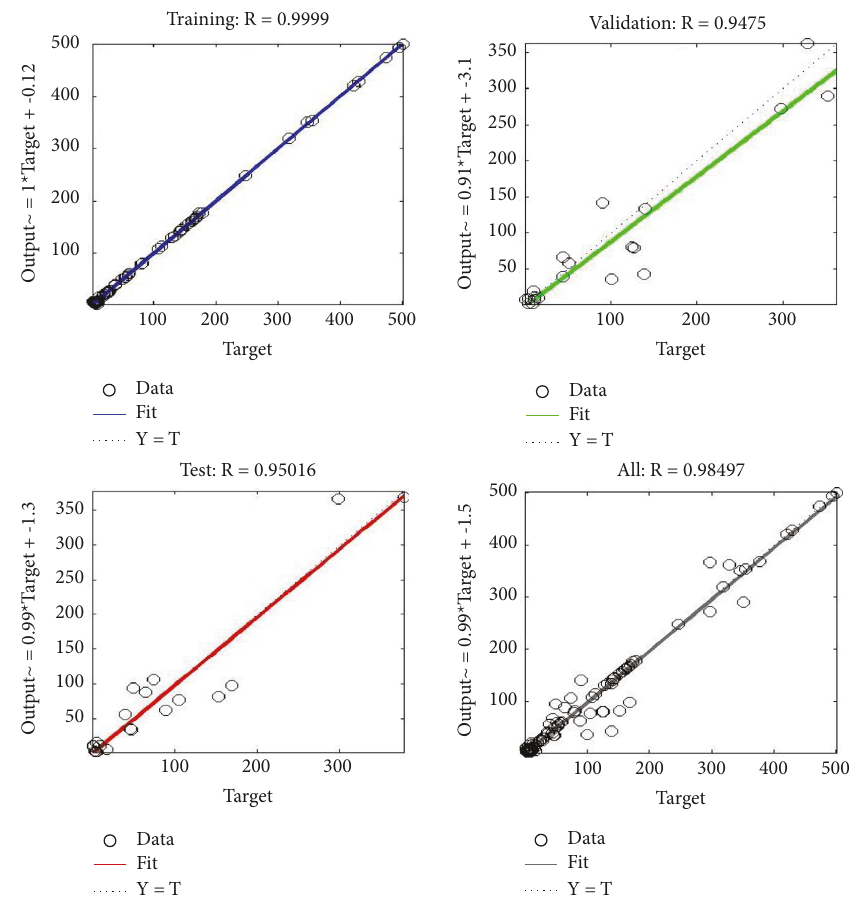
Figure 3: Regression curves of the artificial neural network model showing regression coefficient values for training